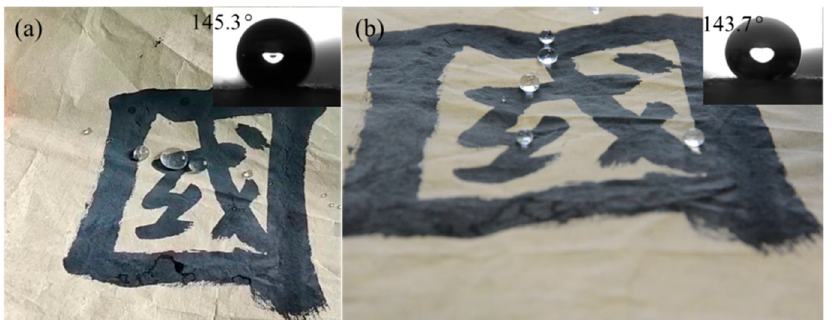
Figure 6 . The WCAs of the treated samples under 300 V and 30 g/h, during two measurements: ( a ) soon after treatment, and ( b ) six months later.